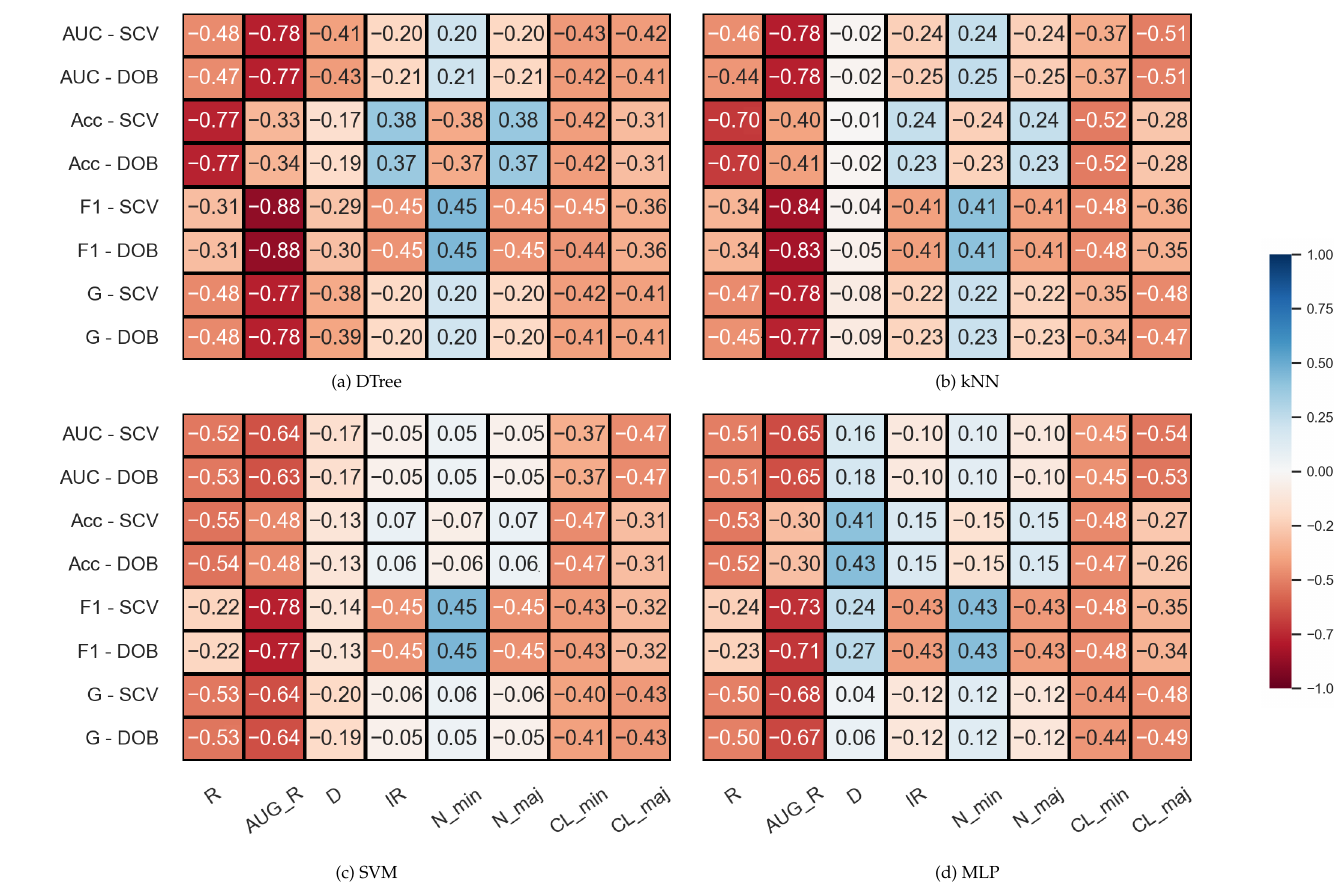
Figure 3. Result of the Spearman’s rank correlation test between some properties of the synthetic data set and the results of the classification combined with oversampling obtained on the data